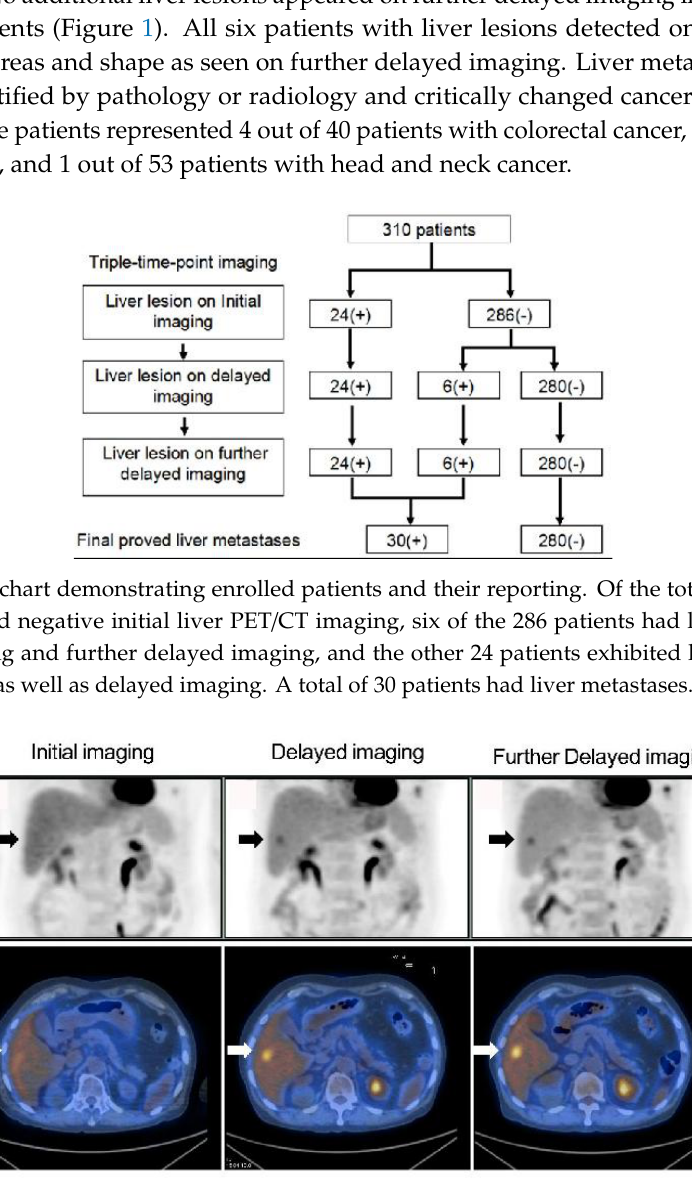
Figure 2. Liver metastases were detected only on delayed FDG PET / CT imaging. Liver FDG maximum-intensity projection (top row) and axial FDG PET / CT imaging (bottom row) of initial (left), delayed (middle) and further delayed imaging (right) in a 62-year-old male patient with nasopharyngeal cancer (NPC) displayed an FDG-avid liver lesion that was detected only on delayed and further delayed imaging but not on initial imaging (arrows). There was slightly more evidence of the liver lesion and increased contrast against normal liver tissue on further delayed imaging as compared with delayed imaging. These images were typical of a liver lesion detected only on delayed FDG PET / CT imaging but not on initial imaging. Pathology confirmed metastatic carcinoma of NPC